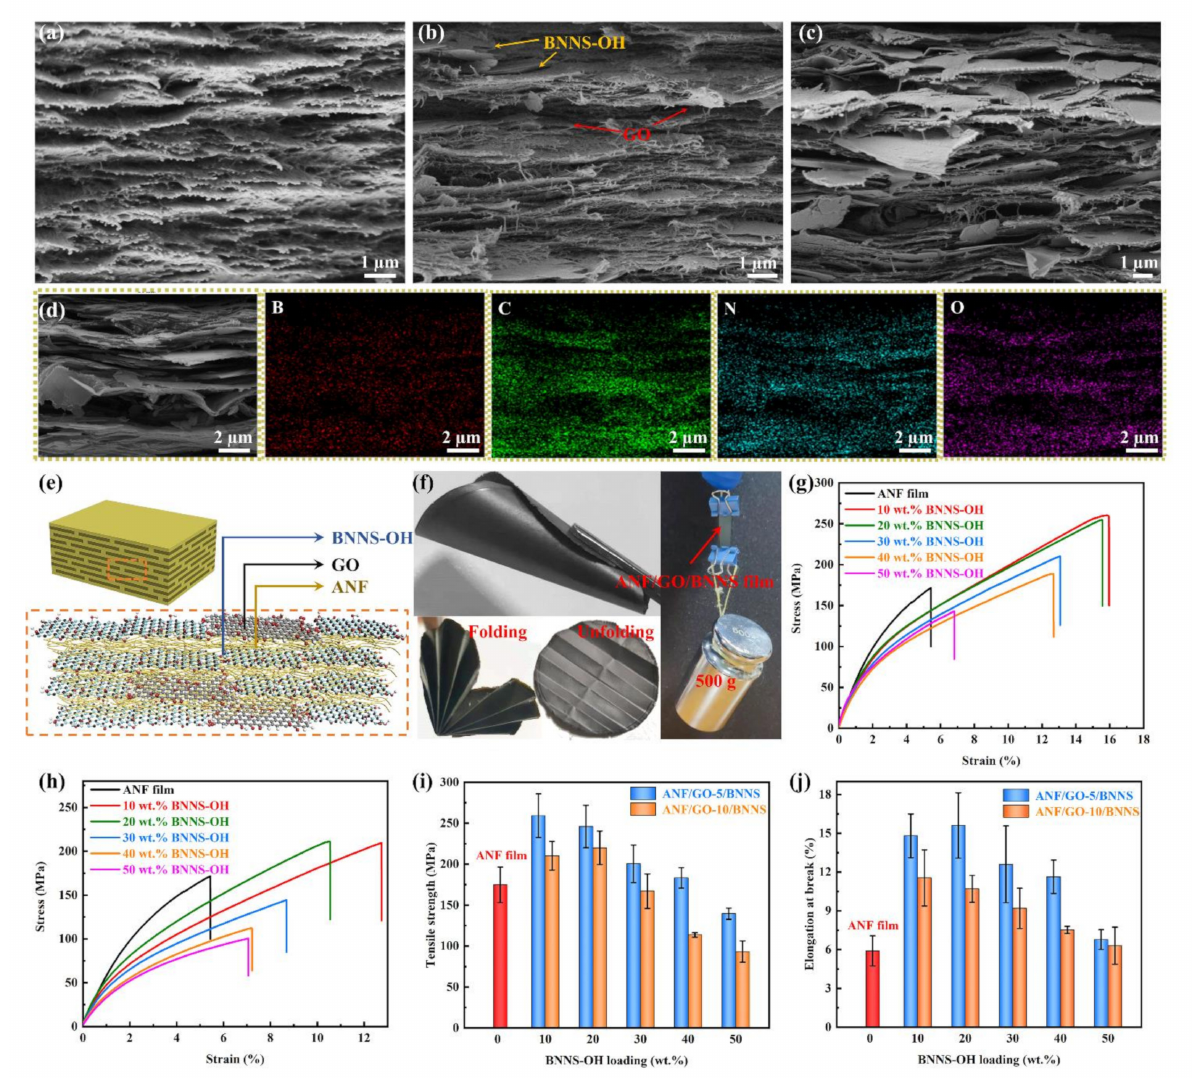
Figure 4. Cross-sectional SEM images of ( a ) ANF film, ( b ) ANF/GO-5/BNNS-10, ( c ) ANF/GO-10/BNNS-50 compos- ite films. ( d ) Energy-dispersive X-ray mapping of elements B, C, N, and O in ANF/GO-10/BNNS-50 composite film. ( e ) Sketch of the nacre-mimetic layered structure. ( f ) Demonstration of high mechanical strength and origami foldability of ANF/GO/BNNS composite films. Typical stress − strain curves of ( g ) ANF/GO-5/BNNS and ( h ) ANF/GO-10/BNNS composite films. ( i ) Tensile strength and ( j ) elongation at break of the ANF/GO/BNNS composite